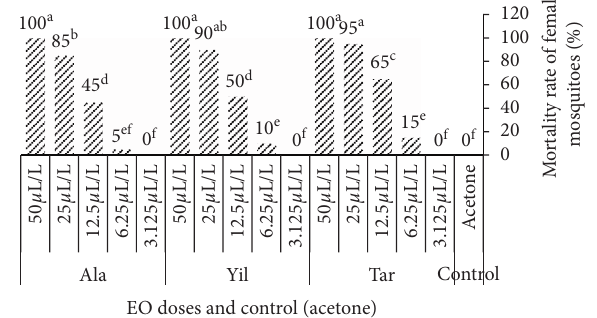
Figure 5: Percent mortality of adult female mosquitoes due to the different concentrations of Ala, Yil, and Tar EOs and the negative control (acetone).